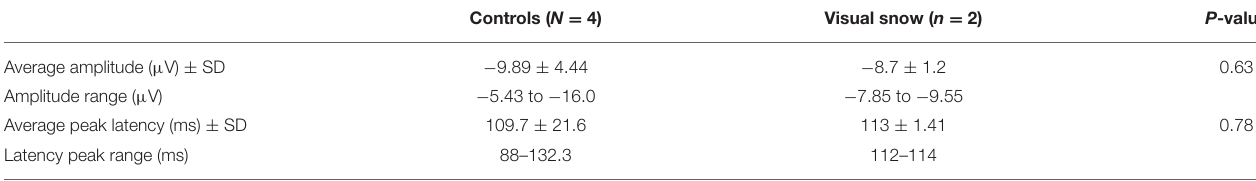
TABLE 1 | C2 component in controls vs. visual